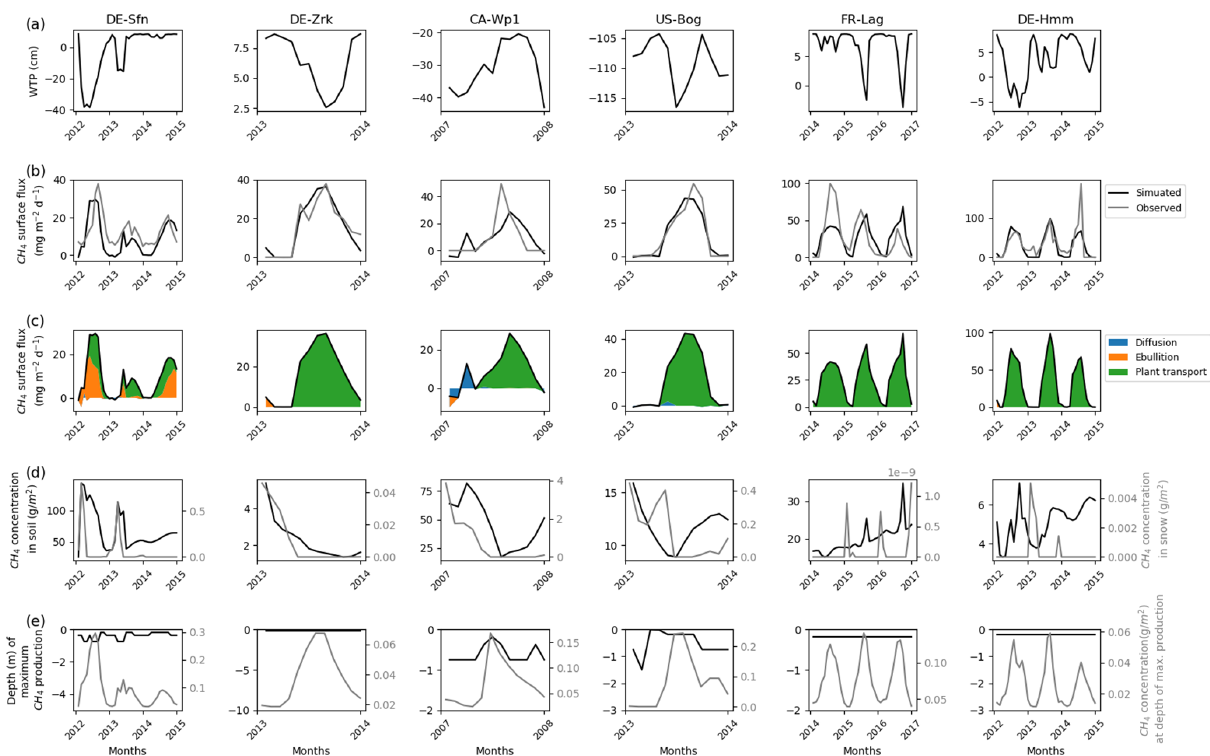
Figure 3. Temporal distribution of methane for sites emitting between 10 and 150mgCH 4 m − 2 d − 1 . (a) Simulated water table position estimated from the soil water content. (b) Simulated (dark line) and observed (gray line) methane emissions released to the atmosphere. (c) Cumulative amount of simulated methane emitted by diffusion, plant-mediated transport, and ebullition. (d) Methane concentration in the soil layers (dark line) and in the snow layers (gray line) of the model. (d) On the left is the depth at which simulated methane production is the highest in the soil, scaled to the maximum peat depth. On the right is the amount of simulated methane produced at these